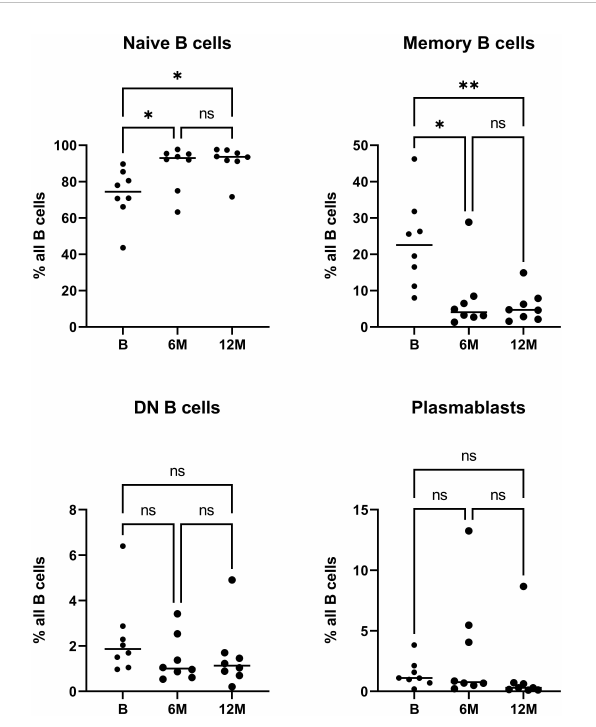
FIGURE 1 Flow cytometric analysis of peripheral blood B cell subsets during cladribine treatment. The relative frequency of naive, memory, DN B cells and plasmablasts prior to initiation of treatment with cladribine (B) and 6 months (6M) and 12 months (12M) after 1st cycle is shown. Asterisk denote signi fi cant (*p<0.05; **p<0.01) differences on Friedmann test with Dunn ’ s multiple comparisons, ns denotes not signi fi cant